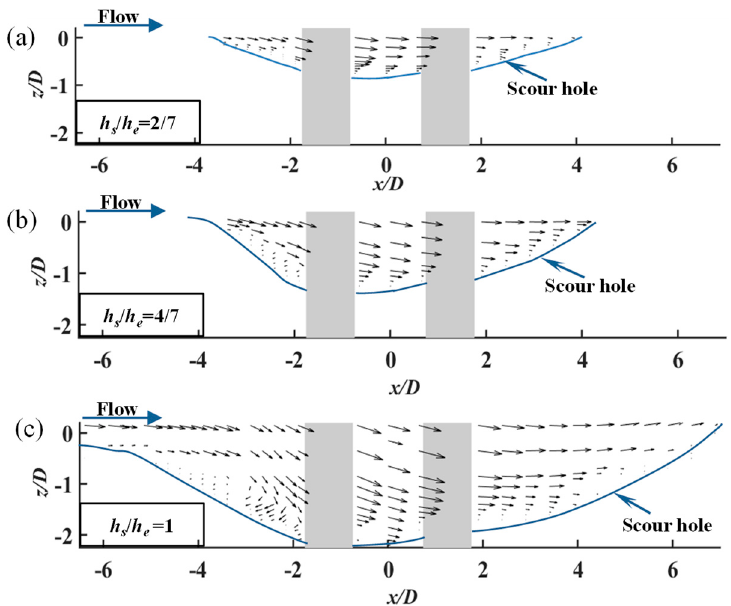
Figure 5. Velocity vectors in the symmetry plane within developing scour holes for ( a ) h s / h e = 2/7, ( b ) h s / h e = 4/7, and ( c ) h s / h e = 1.